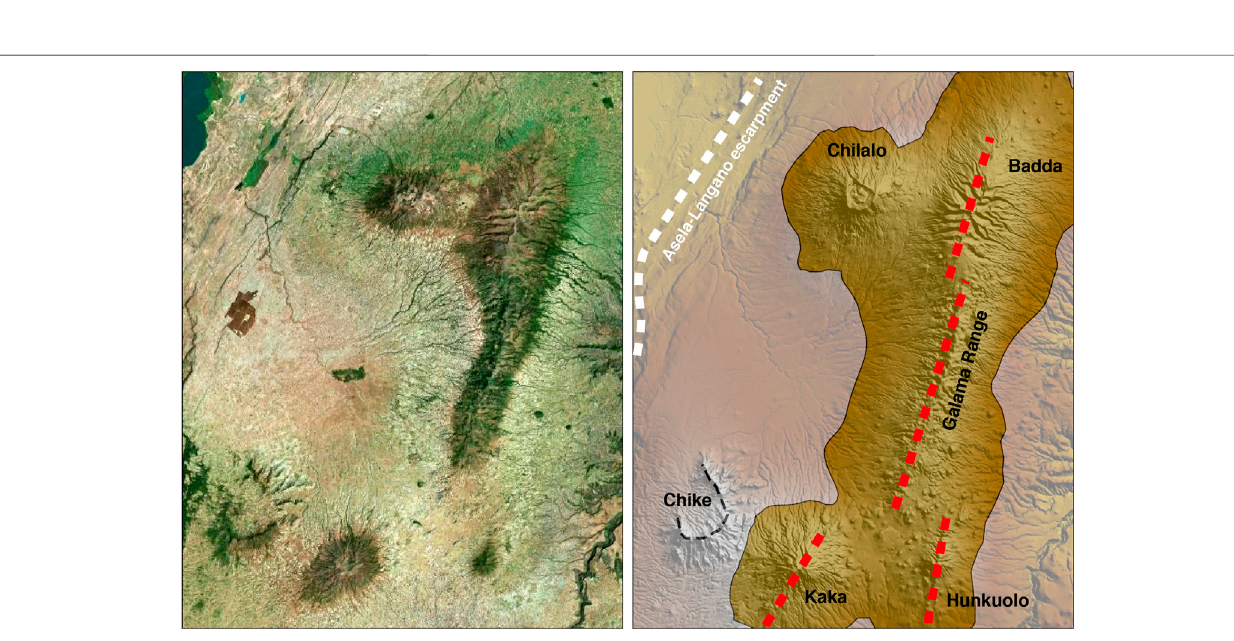
Frontiers in Earth Science |